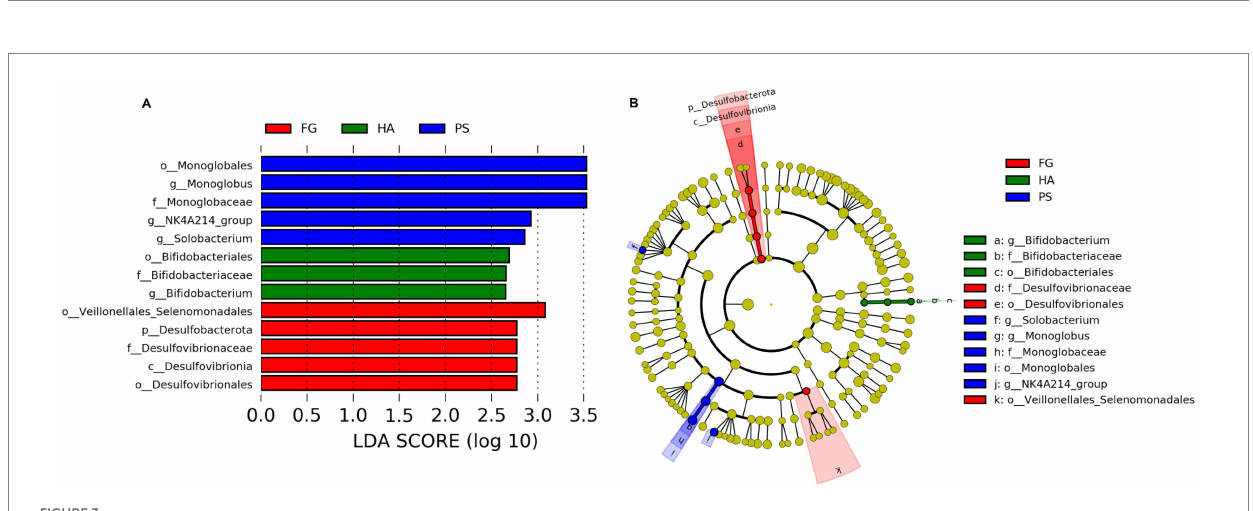
FIGURE 3 Linear discriminant analysis effect size (LEfSe) analysis integrated with linear discriminant analysis (LDA) revealed differentially abundant phylotypes in different groups. LDA scores indicated differences in abundance among forage treatments (LDA scores >2.0) (A) . Cladogram obtained from LEfSe analysis revealed the different taxa in microbiota of different groups of goats (B)